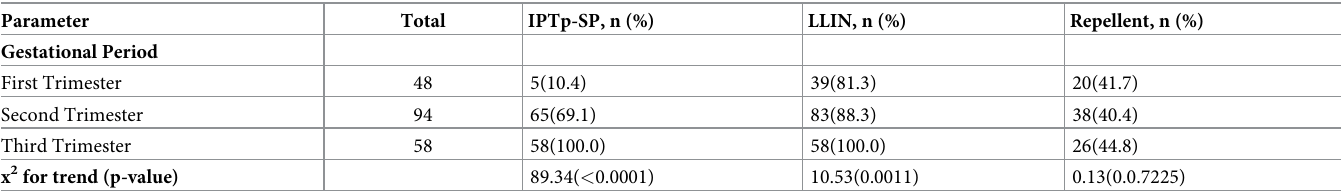
Table 3. Distribution of IPTp-SP, LLIN and repellent use stratified by gestational